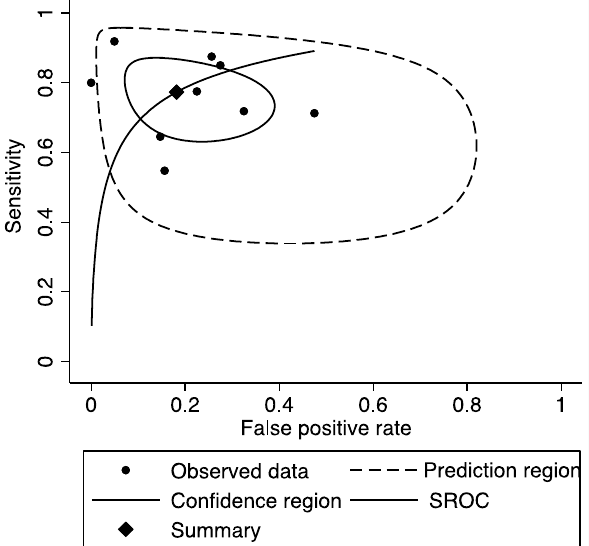
Figure 4. Summary receiver operating characteristic curve (SROC) for miR-21 in CRC diagnosis. We performed meta-regression to investigate the possible source of heterogeneity.